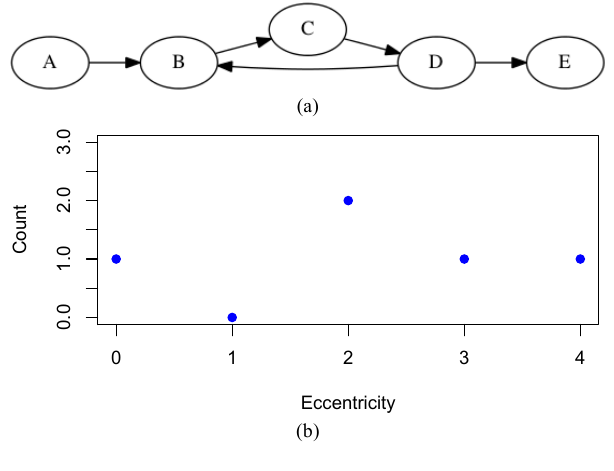
Fig. 4. (a) Motif identified representing a task deviation and (b) its corresponding eccentricity